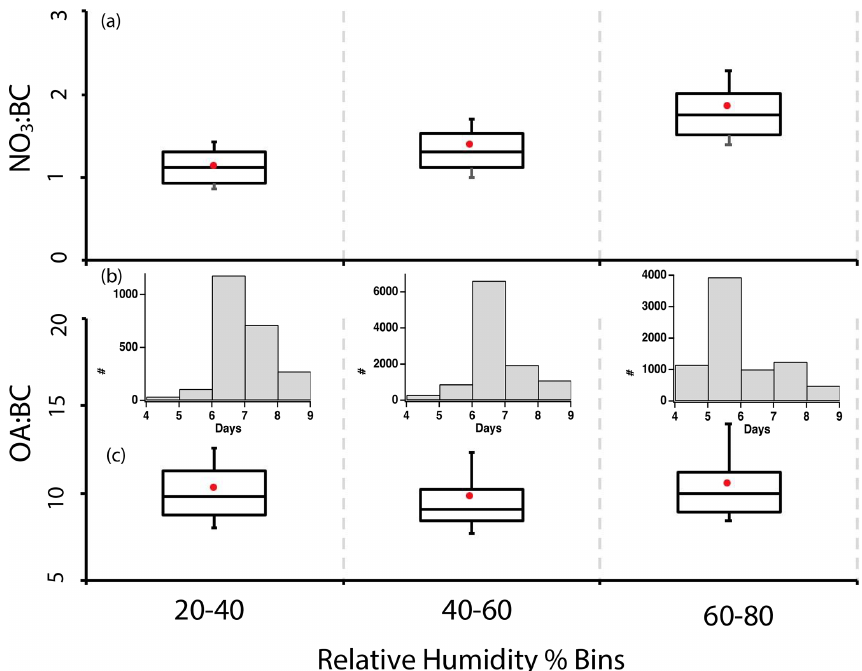
Figure 15. (a) NO 3 : BC and (c) OA : BC mass ratios for the six selected flights as a function of relative humidity for OA > 20µgm − 3 at STP. The 10th, 25th, median, 75th, and 90th percentiles are indicated using box whiskers and the mean with a solid red circle and marker. (b) Corresponding distribution of aerosol ages within each relative humidity range, with the y axis indicating the number of 1s